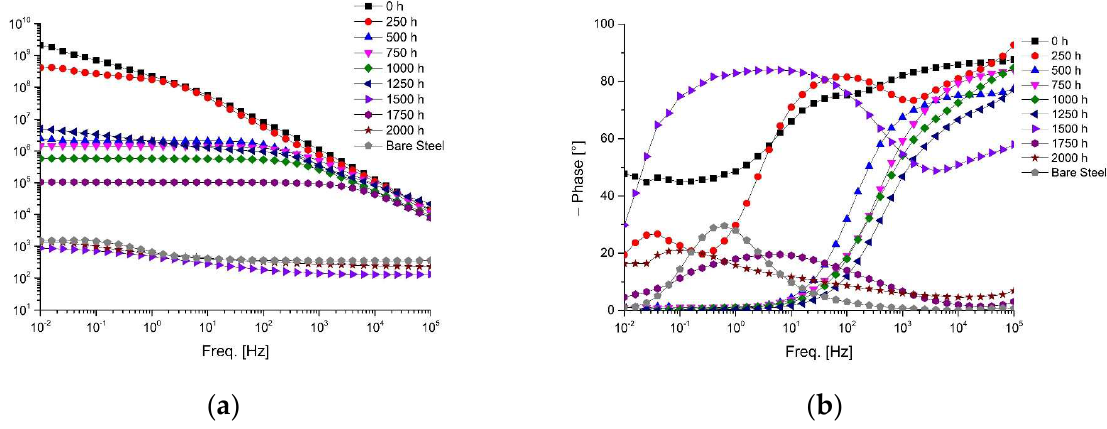
Figure 1. Example of impedance modulus ( a ) and phase angle ( b ) evolution in time for painted steel during NSST.